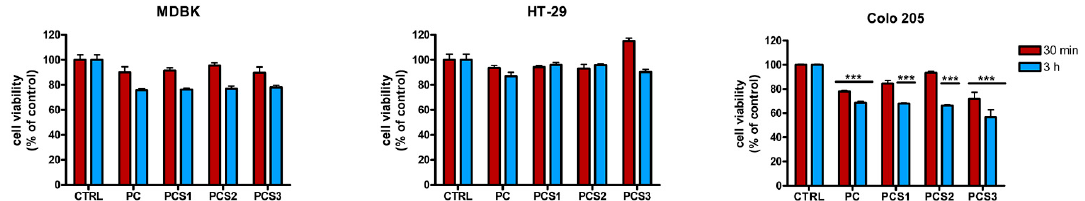
Figure 8. Viability of MDBK (Madin–Darby bovine kidney), HT-29 and Colo 205 cells cultivated in direct contact with nanocomposites systems (PC, PCS1, PCS2, PCS3) for 30 min and 3 h. Cell viability was expressed as percent of control (untreated cells) + standard deviation, *** p value < 0.001 was considered statistically significant.